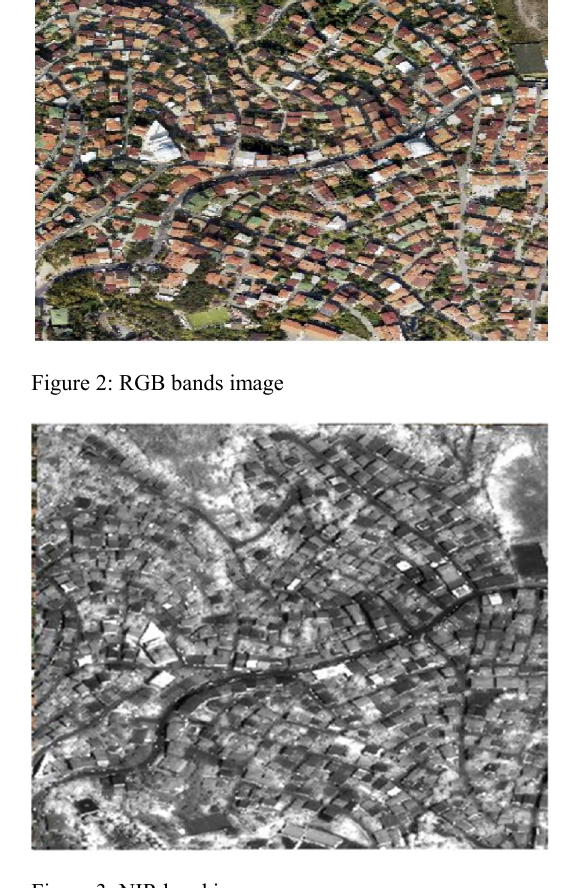
Figure 3: NIR band